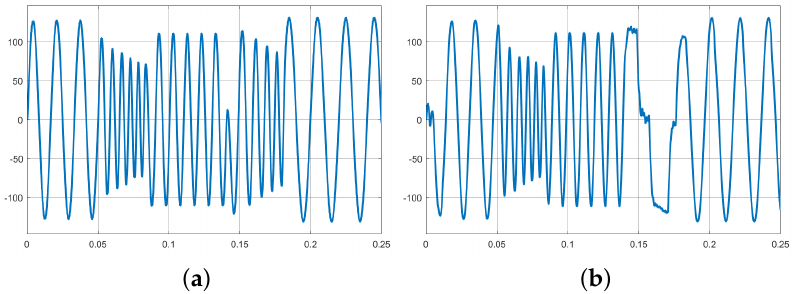
Figure 18. Load voltage waveform with f 0 = 180 Hz, ∆ = 15% and f sw = 2000 Hz, ramp-proportional change of the operating frequency ( a ) SVM, ( b )